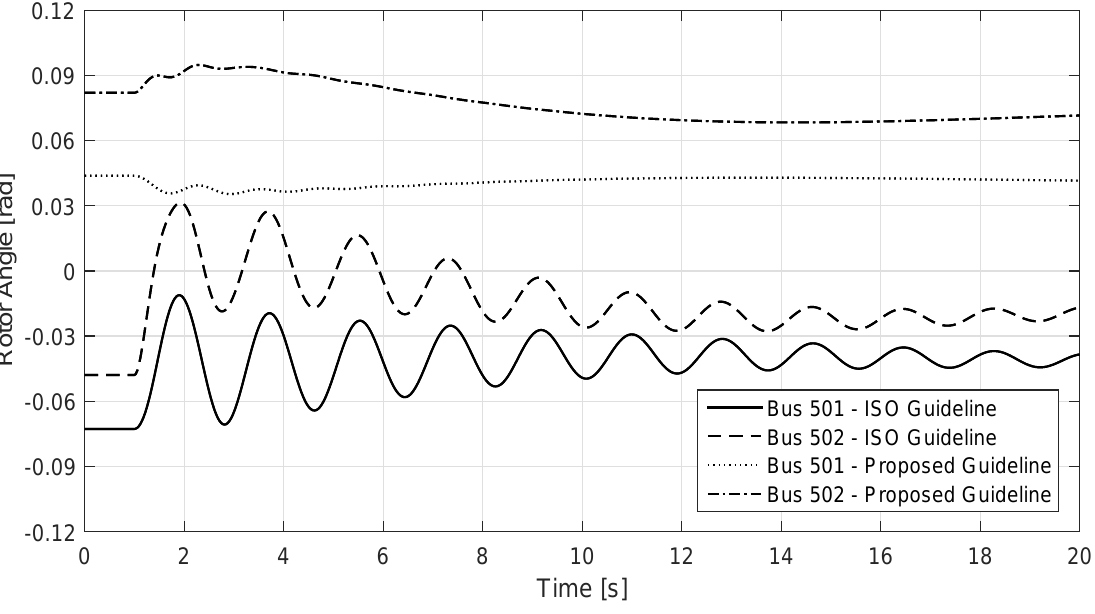
Figure 9. Power plant rotor angle in relation to the system mass center.